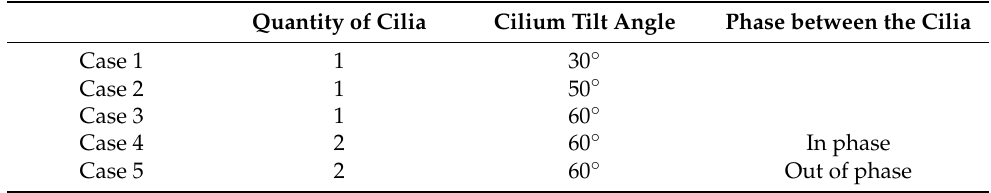
Figure 2. ( a ) Definition of cilium tilt angle. The cilia are connected to the ground and the connection point is stationary during the ciliary beating. ( b ) The dimensions of the flow domain are used as 25 µm × 50 µm. The red line is the ground of the flow domain, which is modeled as a wall with no-slip condition. A non-zero mass flow rate is observed on the yellow line depending on the ciliary motion. ( c ) The geometric configuration of two cilia with no phase difference (Case 4, in phase). ( d ) The geometric configuration of two cilia with phase difference (Case 5, out of phase). For the out of phase configuration, the cilium at the right side completes its cycle, while the cilium at the left is at half of the cyclic motion. Table 1. The modeled cases in CFD simulations.